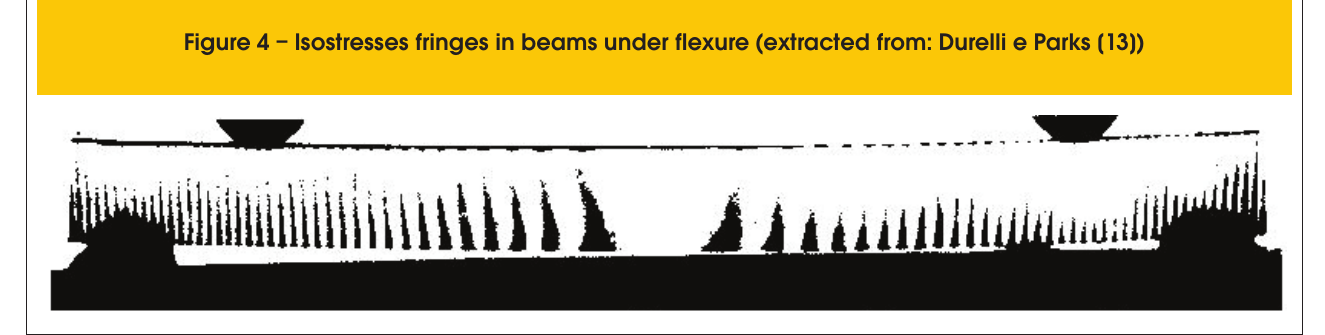
Figure 4 – Isostresses fringes in beams under flexure (extracted from: Durelli e Parks